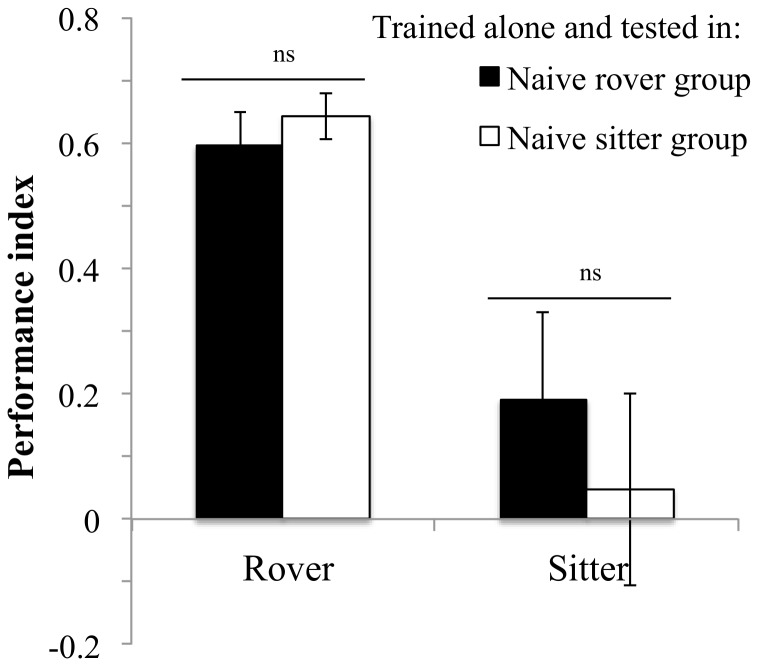
Performance of individually trained flies when tested within a group of naive rovers or naïve sitters.Rover: naive rover group: PI = 0.59±0.04 N = 7 PI; naive sitter group: PI = 0.64±0.06 N = 7 PI. Sitter: naive rover group: PI = 0.19±0.09 N = 7 PI; naive sitter group: PI = 0.04±0.08 N = 7 PI. Error bars represent ±SEM. Comparison between treatments. ns: P>0.05; *: P<0.05; **: P<0.01; ***: P<0.001.